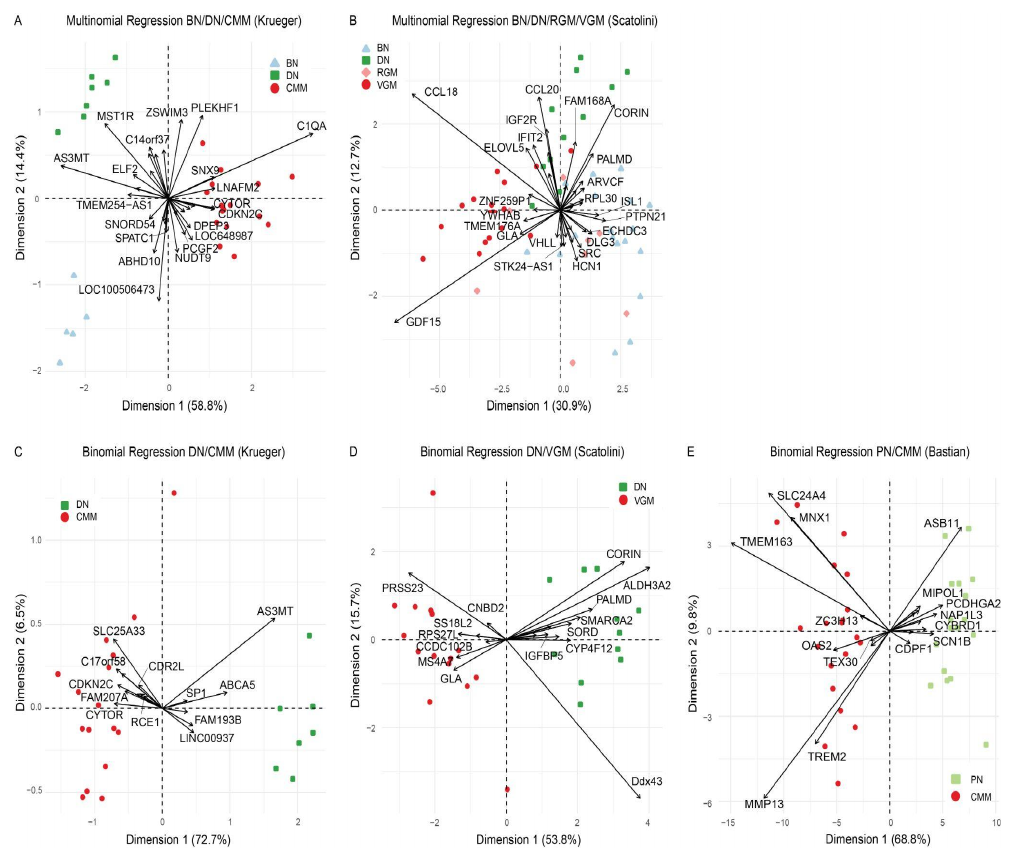
Figure 2. Regularized regression models differentiate nevi and melanoma. Multinomial regression models for ( A ) benign nevi (BN) vs. dysplastic nevi (DN) vs. cutaneous malignant melanoma (CMM) in the Krueger dataset and ( B ) BN vs. DN vs. radial growth phase melanoma (RGM) vs. vertical growth phase melanoma (VGM) in the Scatolini dataset. Binomial regression models for ( C ) DN vs. CMM in the Krueger dataset, ( D ) DN vs. VGM in the Scatolini dataset, and ( E ) progressing nevi (PN) vs. CMM in the Bastian dataset.